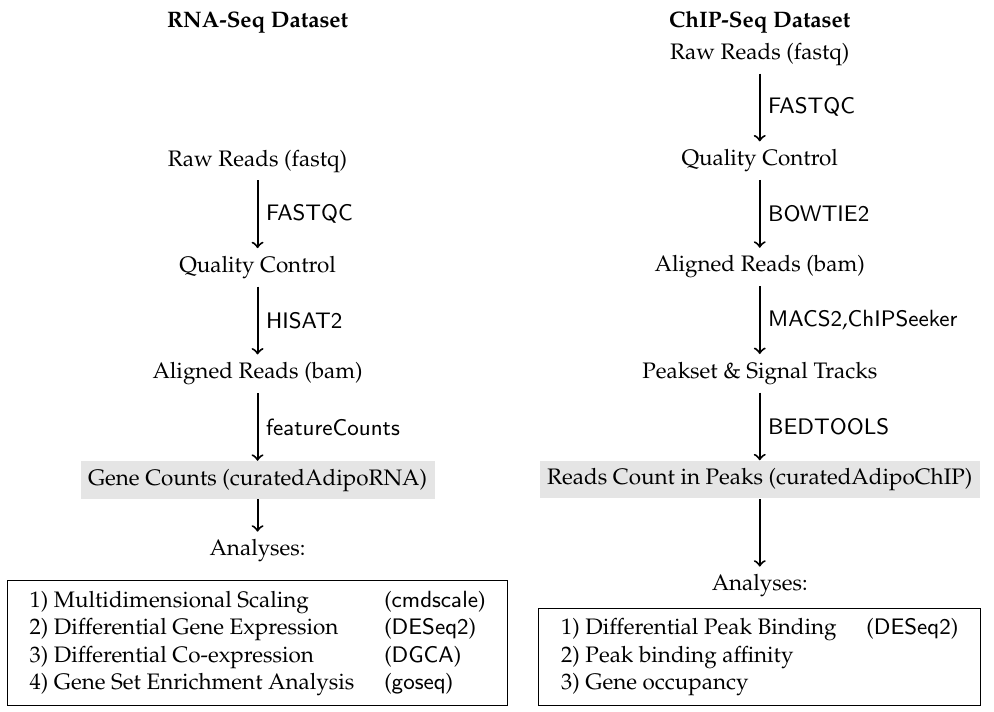
Figure 1. Data pre-processing, processing and analyses’ workflow of RNA-Seq and ChIP-Seq